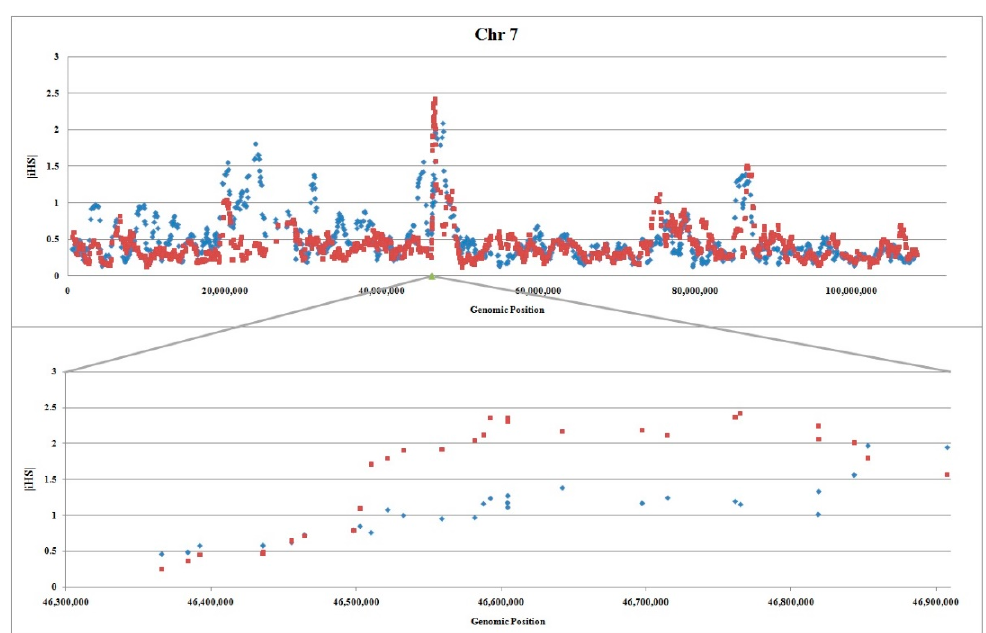
Figure 2. Plot of |iHS| in relation to the genomic position (bp) for thin and fat tail breeds on chromosome 7 ( Upper ) and our candidate region ( lower ): Fat and thin tail breeds are shown by blue diamonds and red squares respectively, and |iHS| statistic averaged over 10 SNPs. The information for calculating |iHS|on whole chromosome was obtained from Moradi et al. [3].